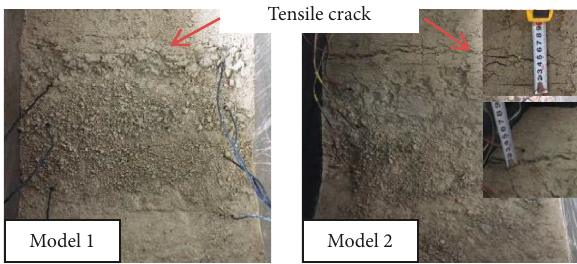
Figure 7: Vertical view of model surface after slope failure.